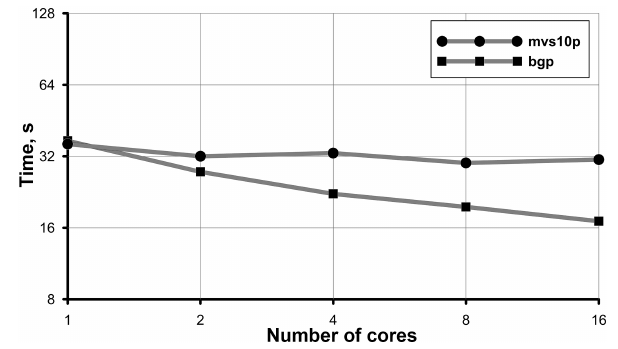
Figure 5. Wall-clock time of parallel writing of a model array of 4096 × 2048 × 50 size by different numbers of CMF2.0 coupler cores on MVS-10P and BlueGene/P